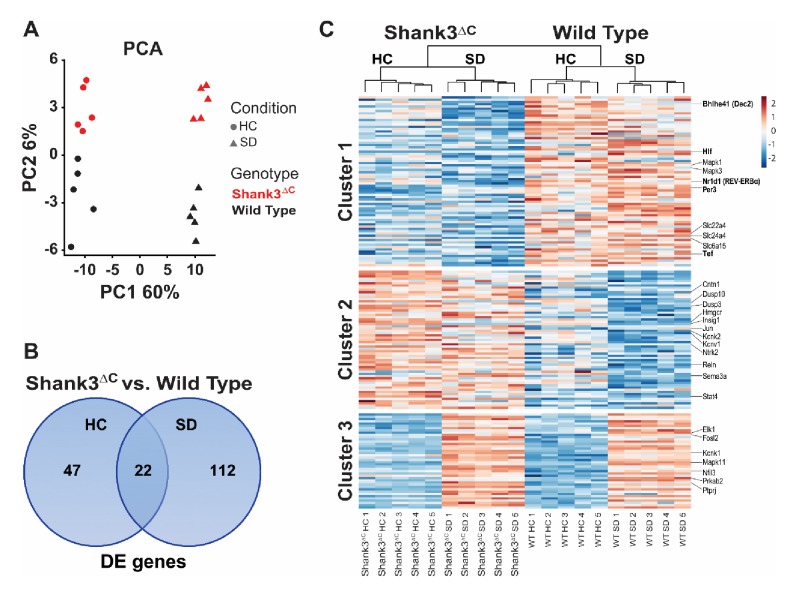
Sleep deprivation induces a two-fold difference in gene expression between Shank3ΔC and wild type mice.RNA-seq study of gene expression from prefrontal cortex obtained from adult male Shank3ΔC and wild type mice either under control homecage conditions (HC) or following 5 hr of sleep deprivation (SD). N = 5 mice per group. (A) Principal component analysis of normalized RNA-seq data shows that sleep deprivation is the main source of variance in the data (first principal component, PC1) and genotype is the second (second principal component, PC2). Percent variance explained by each PC is shown on each axis. (B) Venn diagram showing the number of genes differentially expressed at FDR < 0.1 between Shank3ΔC and wild type mice in either control HC conditions or after SD. (C) Heat map of average scaled gene expression for all genes in (B). K-means clustering defined three clusters based on differences in gene expression across all comparisons. Genes belonging to the MAPK pathway and involved in circadian rhythms (see Table 2) are highlighted on the right.
10.7554/eLife.42819.017Figure 4—source data 1.Genes differentially expressed between Shank3∆C vs. wild type mice.RNA-seq study of gene expression from prefrontal cortex tissue obtained from adult male Shank3ΔC and wild type (WT) mice, either under control homecage conditions (HC) or following 5 hr of sleep deprivation (SD). N = 5 mice per group. False discovery rate (FDR) < 0.1.